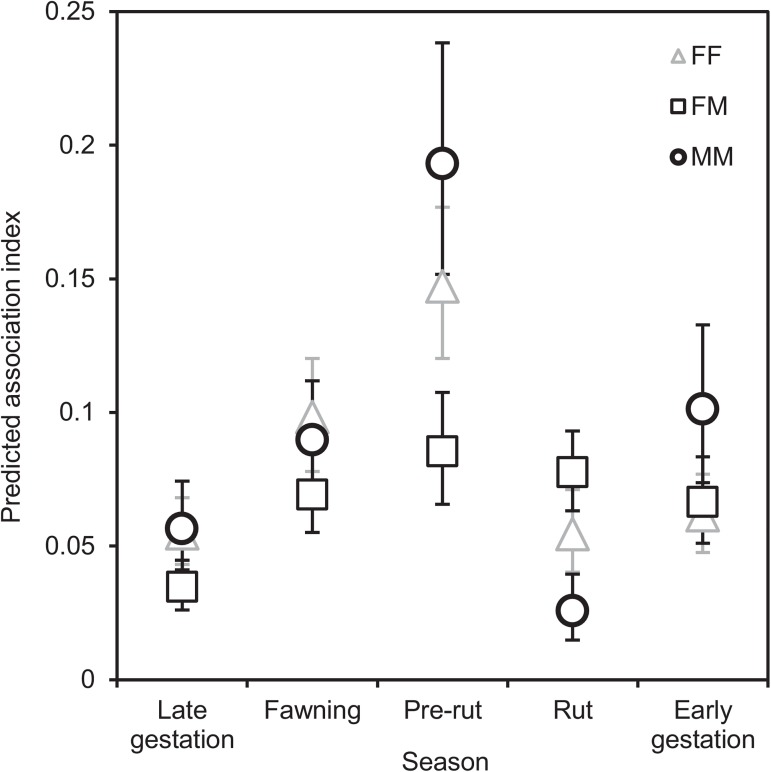
Seasonal predicted pairwise spatial association indices by sex class among adult mule deer.FF are pairs of females, MM are pairs of males, and FM are female-male pairs. Error bars are 95% CI. See S2 Fig for observed values; for values used to generate this graph, see Table H in S4 Appendix.